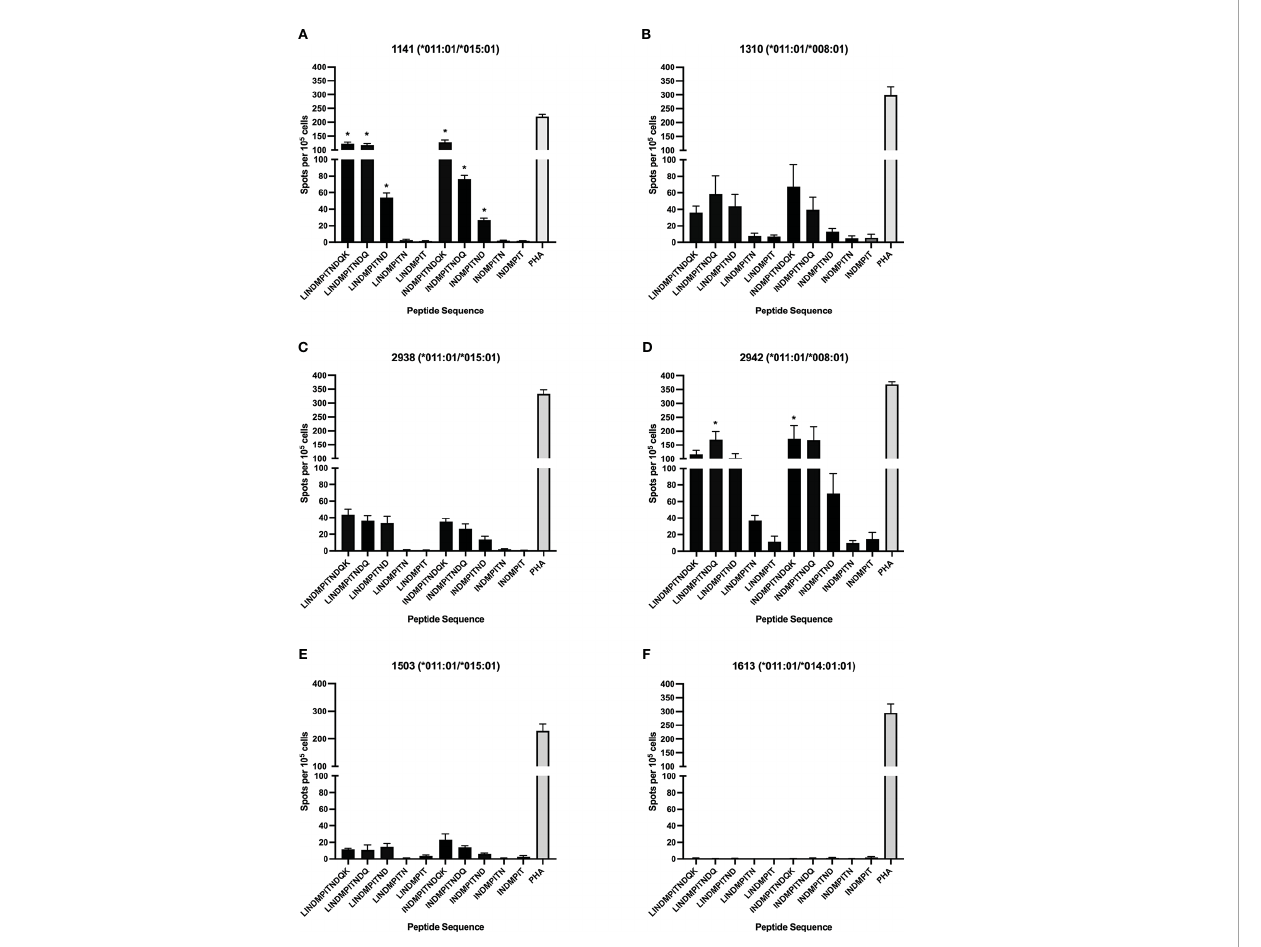
FIGURE 2 Identi fi cation of the minimum peptide of a CD4 + T cell epitope in BRSV-375 F protein. C-terminal truncated peptides were used to stimulate CD4 + T cells in culture with autologous DRB3*011:01 antigen presenting cells. T cell stimulation was observed for peptides greater than 8 amino acids in length. The 9-mer minimum peptide sequence of INDMPITND was identi fi ed. T cells were stimulated with PHA at a concentration of 5 m g/mL as a positive control, and cRPMI media as a negative control. Cows 1141 (A) and 2942 (D) had a signi fi cantly higher response to peptides containing the core INDMPITND sequence while T cells from 1310 (B) , 2938 (C) , 1503 (E) responded to these peptides, the results were not signi fi cant. T cells collected from cow 1613 (F) did not produce an observable response to peptide stimulation. Data presented as mean ± SEM, p < 0.05 was considered signi fi cant and indicated by